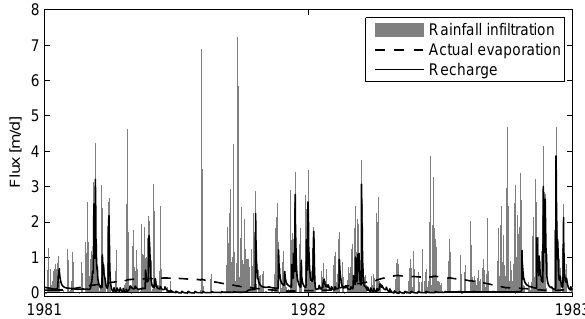
Fig. 3. Simulated recharge compared with infiltration and actual